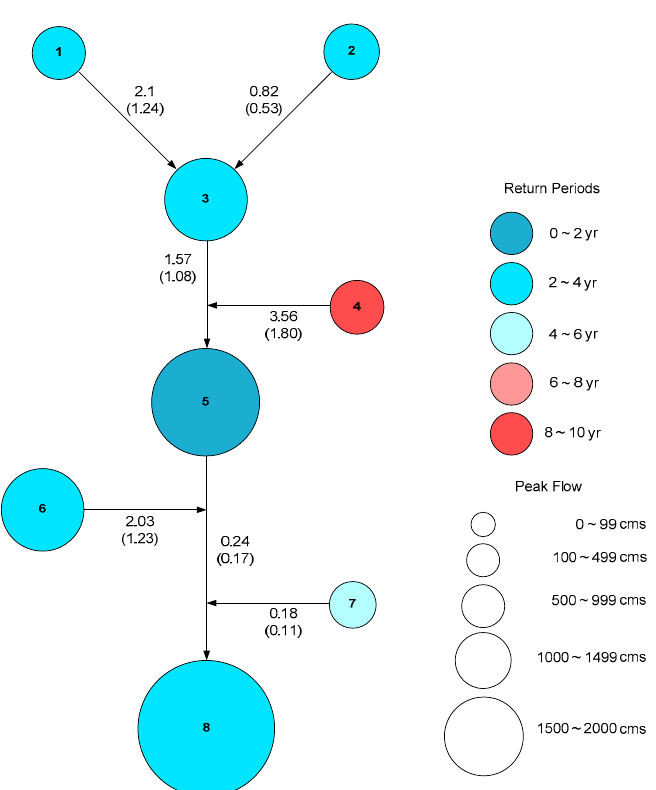
Figure 10. Results of streamflow simulations for sub-basins. The circle size and color indicate the magnitude of the peak flow and the return period for each sub-basin, respectively. The number on the arrow shows the maximum streamflow velocity (mean velocity, m/s).